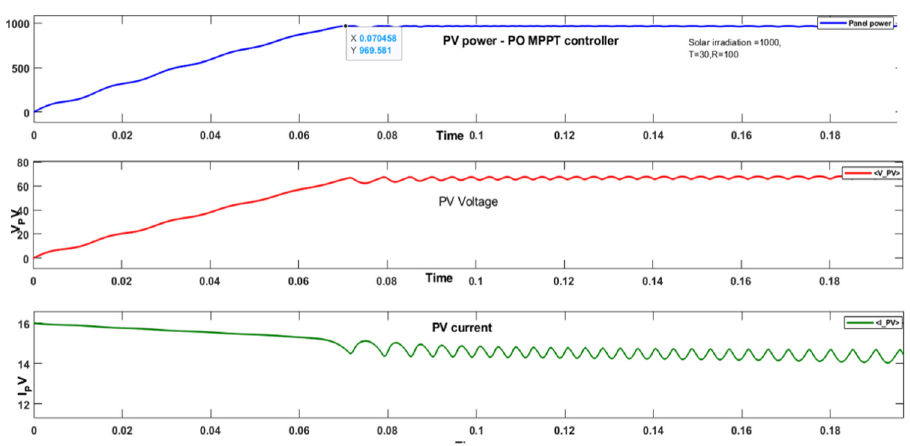
Figure 11. PV power, PV voltage and PV current responses of the solar PV panel with the P&O MPPT controller under solar radiation = 1000 W/m2, T = 30 °C (deg. Celsius), load R = 100 ohms.